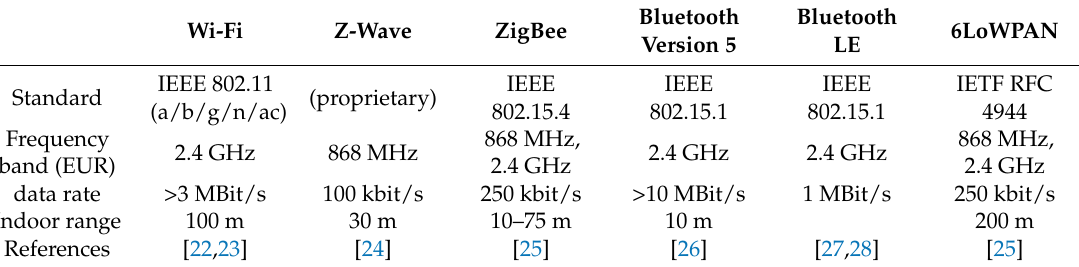
Table 1. Common Standards for local sensor